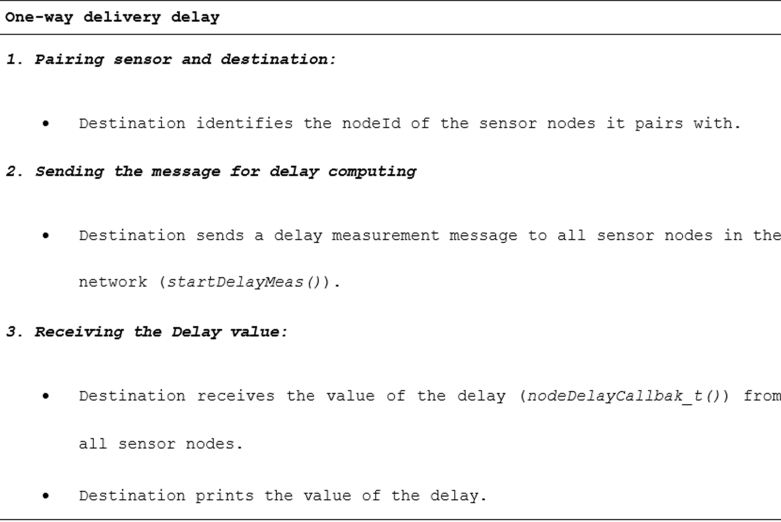
Figure 8. Algorithm used for one-way delivery delay calculations.